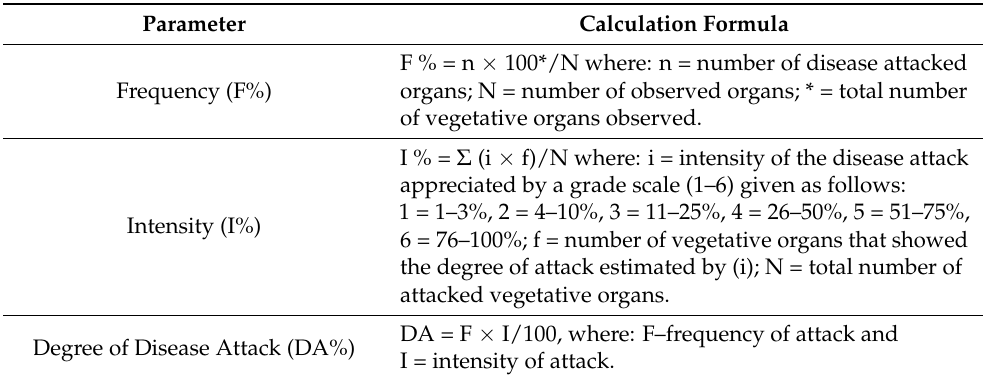
Table 13. Parameters estimated in field testing trials of natural-based products treatments applied on organic blackberry and raspberry during